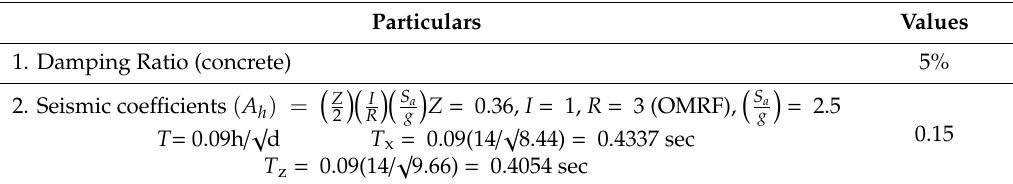
Table 4. Parameter used for earthquake loading.